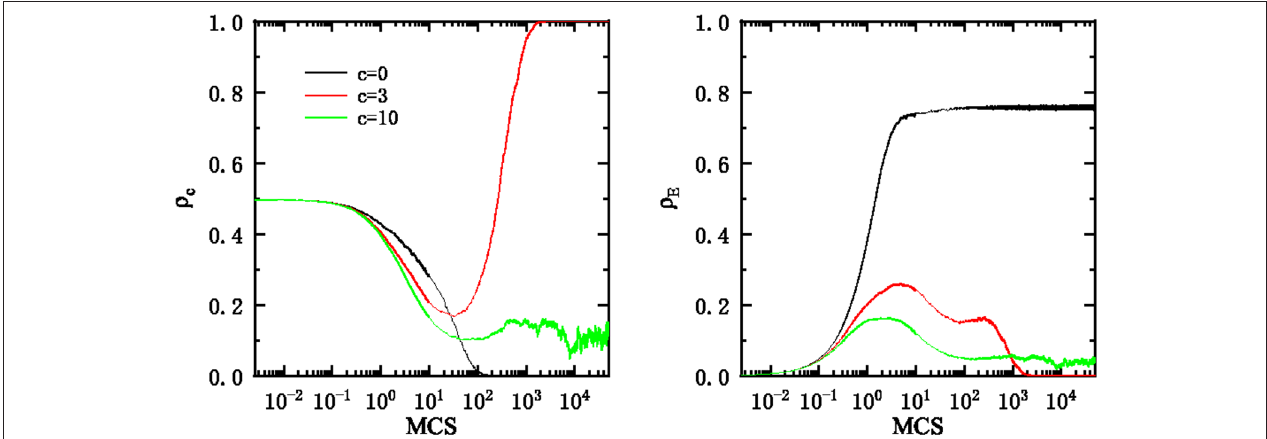
FIGURE 5 | (Left) Time courses of the frequency of cooperation ( ρ c ). (Right) Time courses of the frequency of the inactive players ( ρ E ). The parameters are the same as in Figure 2 . To distinguish different values of exit cost, we use black, red, and green to denote the case of γ = 0, γ = 3, and γ = 10,